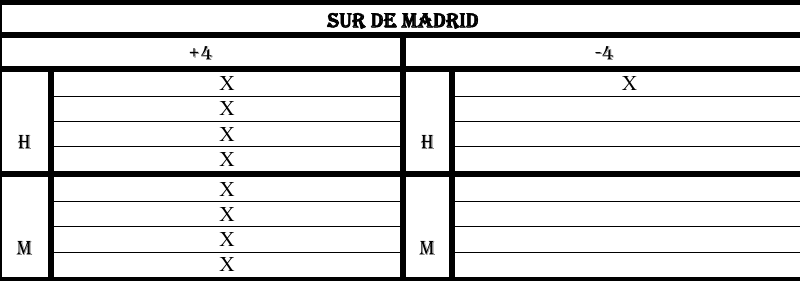
Figure 4. Data on the informants surveyed in the southern area of Madrid.